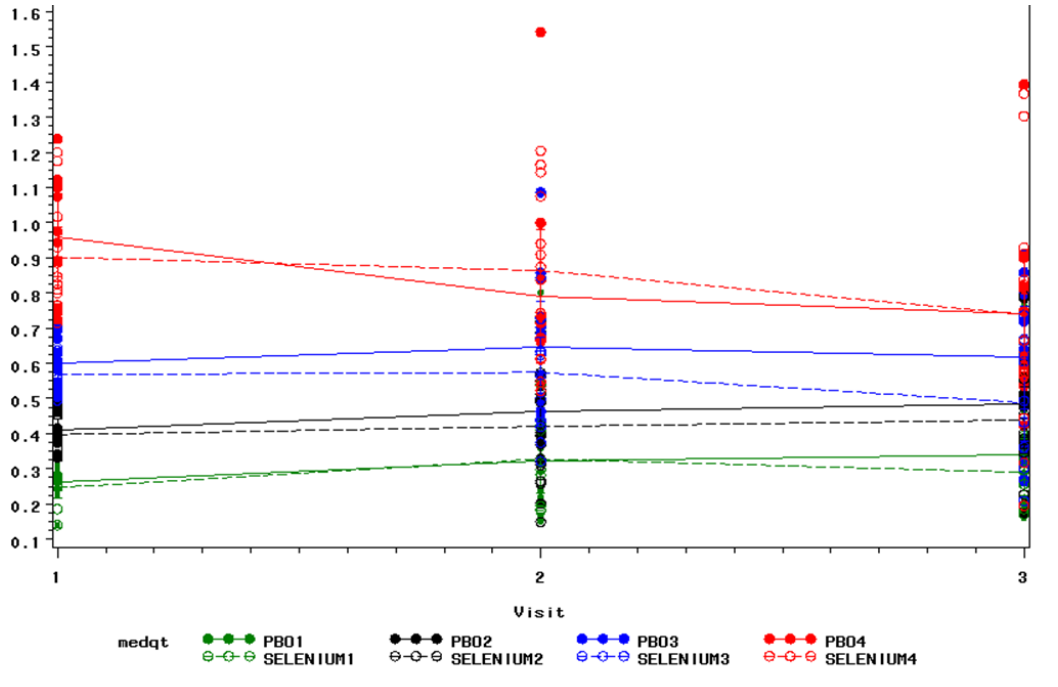
Figure 2. 8-isoprostane-F2 α by Quartiles.